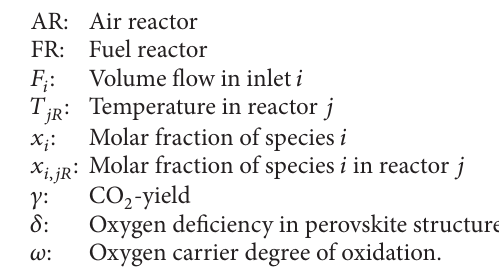
particles is shown in Figure 10. The decomposition was not detected for CaMn 0.775 Mg 0.1 Ti 0.125 O 3−𝛿